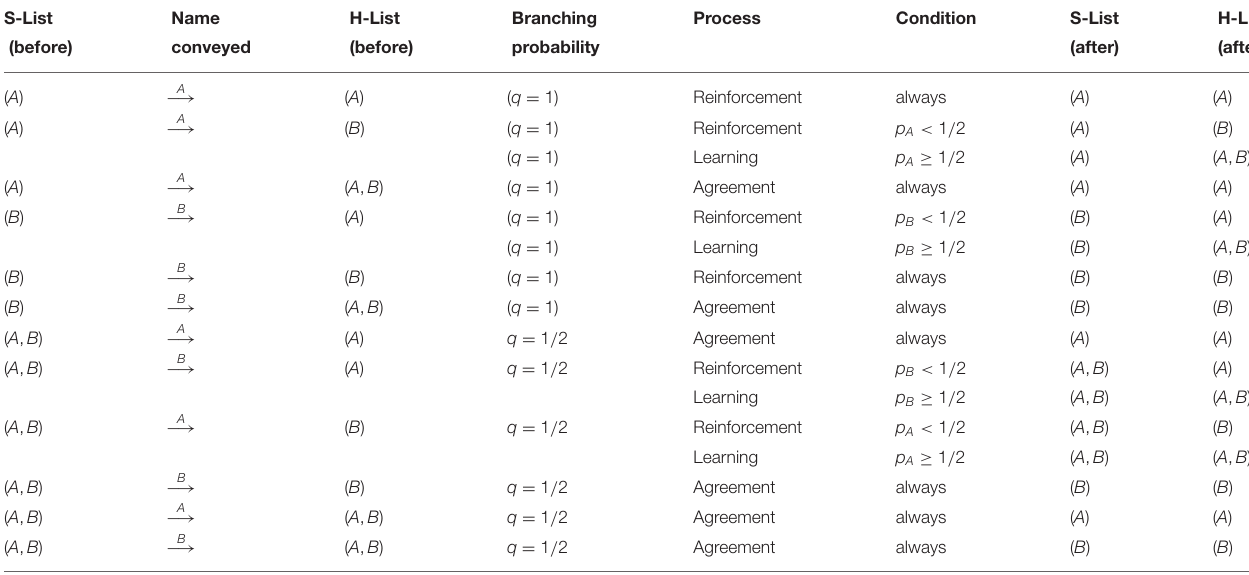
TABLE 1 | Pair-wise interactions in the Bayesian NG